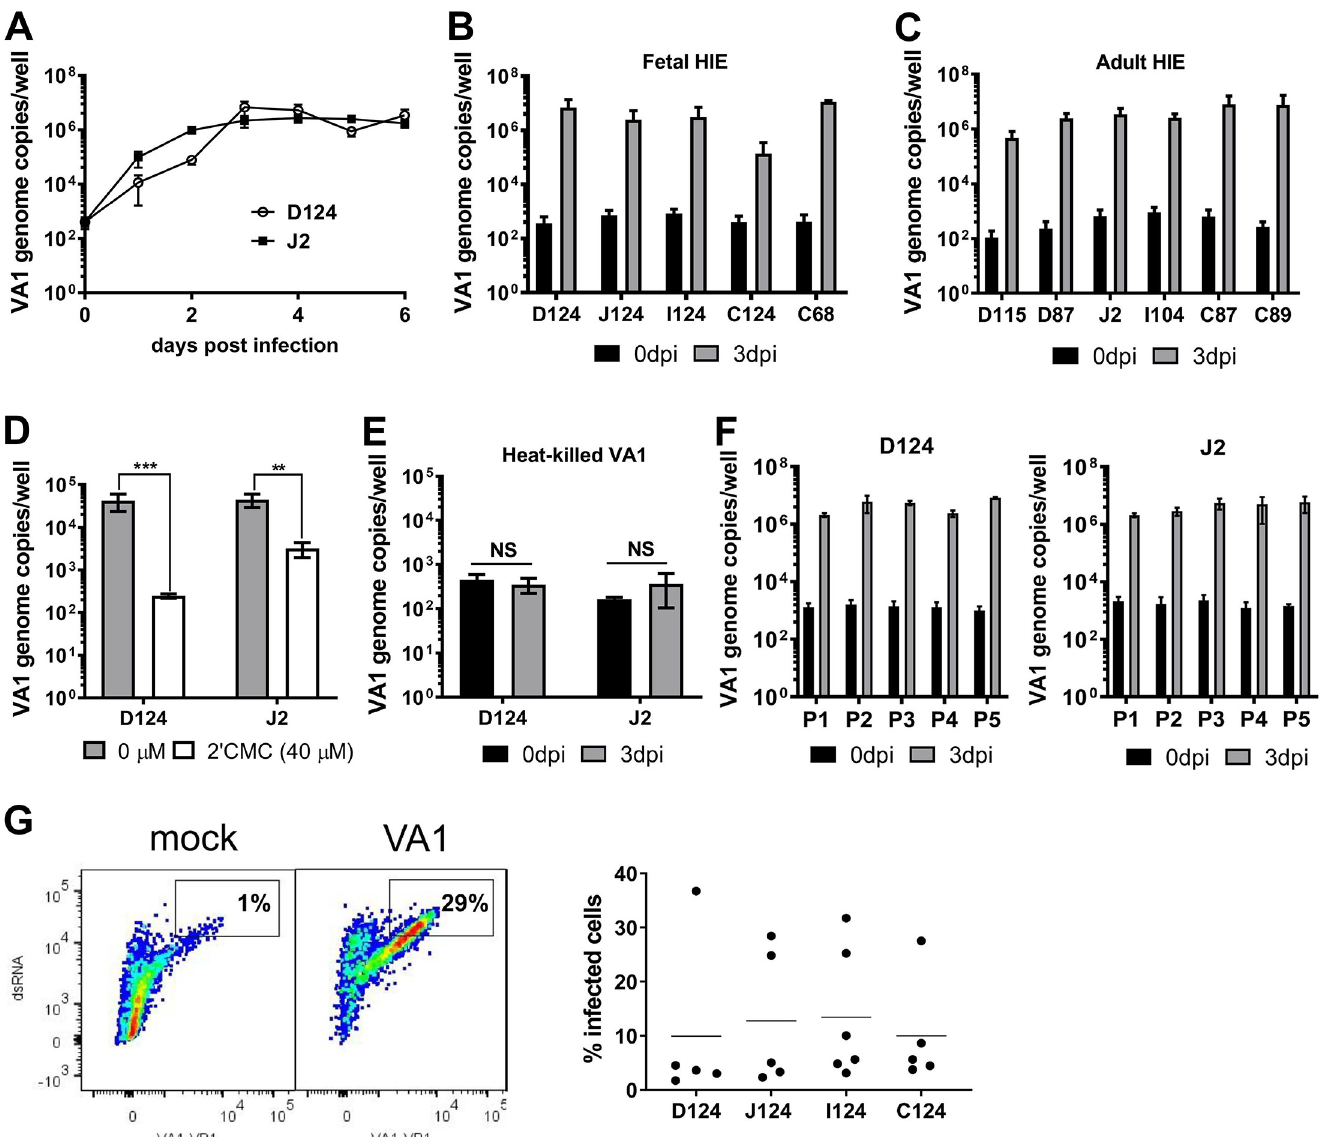
Fig 1. VA1 replicates in human intestinal enteroids (HIE). A) VA1 growth curve. Undifferentiated D124 and J2 HIE were cultured in 2D monolayers and infected with VA1 (MOI of 1). At indicated times, HIE were harvested and viral RNA was extracted and quantified by RT-qPCR. B-C) Undifferentiated HIE derived from indicated segments of fetal and adult intestines were infected with VA1 and analyzed as before. D) VA1 replication is blocked by the nucleoside analogue 2’-C- methylcytidine (2CMC). Undifferentiated D124 and J2 HIE were infected as before and cells treated with 40 μ M 2CMC after adsorption. Cells were harvested and viral RNA quantified at 1 dpi. E) Heat-killed VA1 does not replicate in HIE. VA1 was heat-killed for 3 min at 100˚C prior to infection of undifferentiated D124 and J2 HIE. Cells were harvested and viral RNA quantified at 3 dpi. F) VA1 remains infectious for 5 passages in HIE. Supernatant from infected D124 or J2 (passage 1, P1) containing ~10 3 genome copies/ml was used to infect monolayers of D124 and J2, respectively. Cells were harvested and viral RNA quantified at 3 dpi. The procedure was repeated four times (P2-P5). For all experiments, viral genome copies were measured by RT-qPCR. A–F) Data are from � 3 experiments; error = mean ± SD. G) A single cell suspension of VA1-infected (MOI of 1) D124, I124, J124 and C124 HIE was generated at 3 dpi and stained with antibodies against dsRNA and VA1 capsid protein prior to flow cytometry analysis. The left panel is a representative flow plot of mock- and VA1-infected J124 HIE. The right panel represents